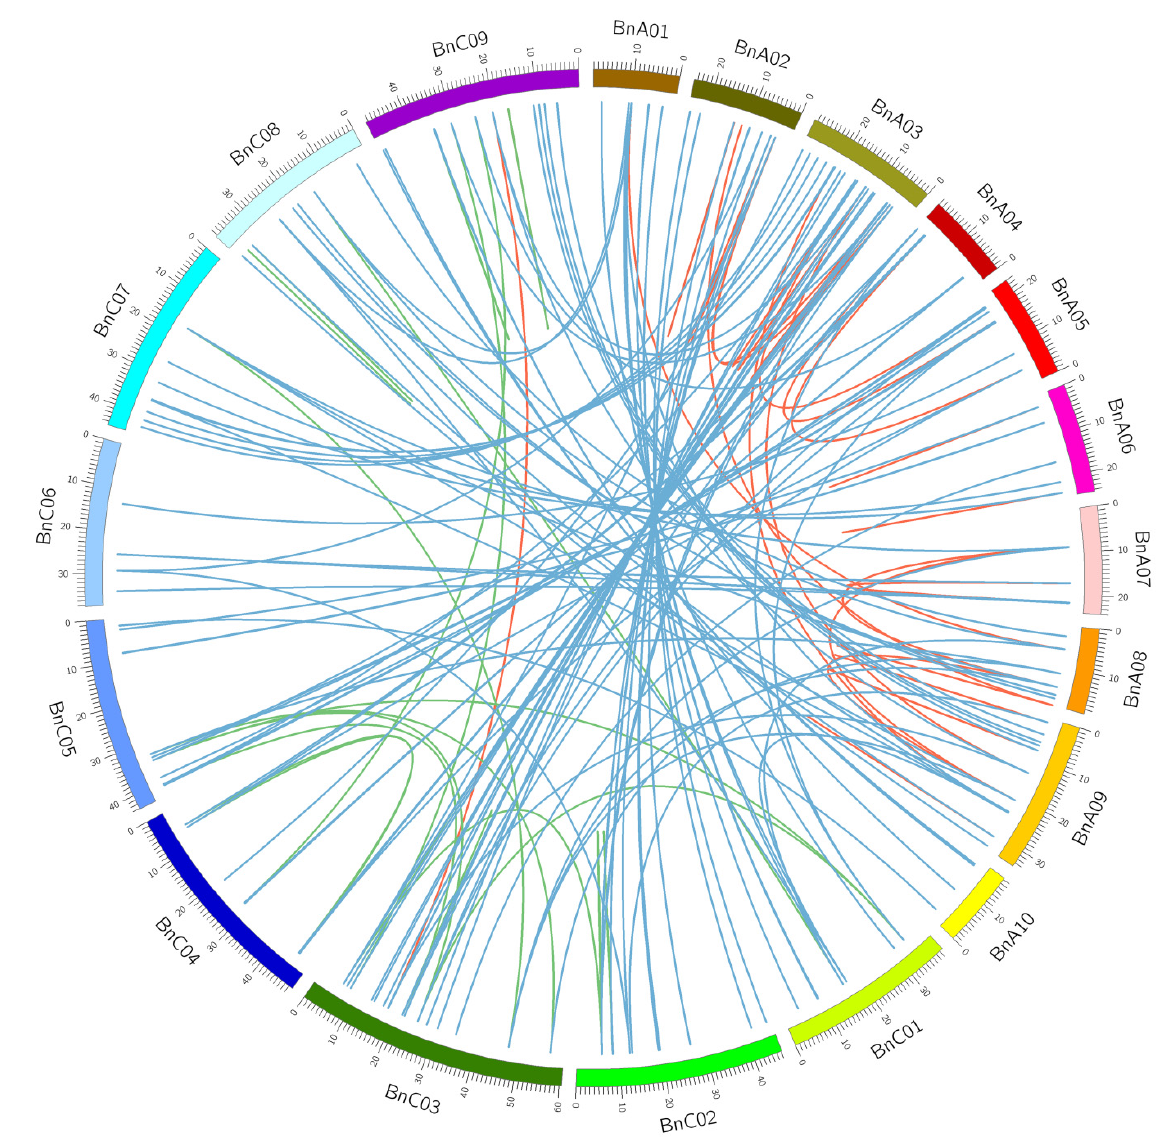
Figure 3. Genome-wide synteny analysis for nsLTP genes in B. napus . BnA01–10 and BnC01–09 repre- sented chromosomes in A and C sub-genomes in B. napus , respectively. Red, green and blue lines linked the syntenic gene pairs within BnA-BnA, BnC-BnC and BnA-BnC subgenomes of B. napus , respectively.